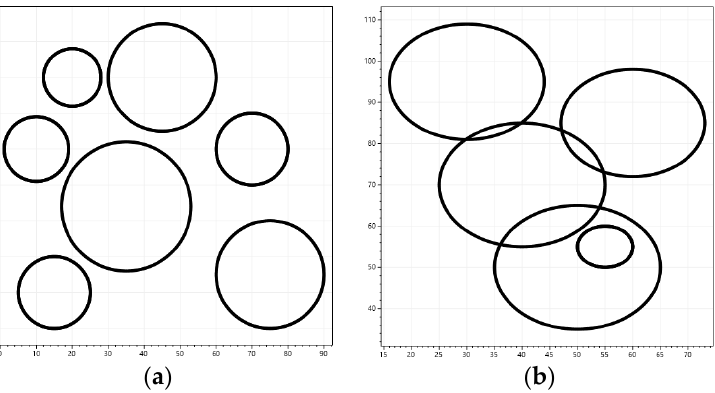
Figure 6. Example of cases, when corresponding optimization problem does not have a solution: ( a ) case without coverage radiuses intersection; ( b ) full coverage zone overlapping case.